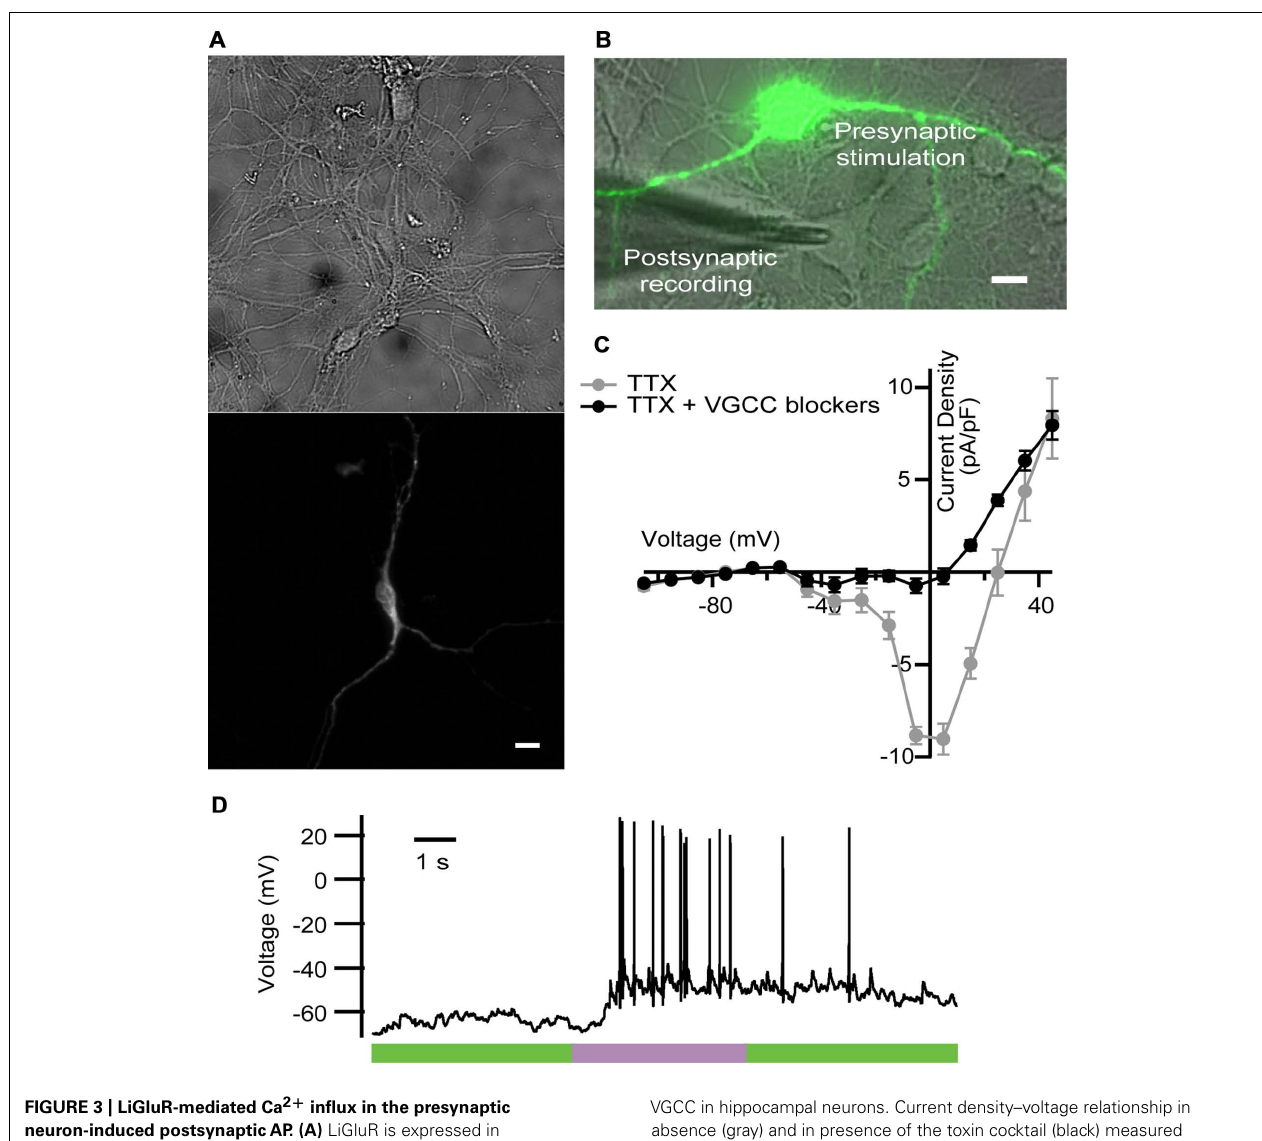
FIGURE 3 | LiGluR-mediated Ca 2 + influx in the presynaptic neuron-induced postsynapticAP. (A) LiGluR is expressed in the neuron soma and in all processes, as indicated by fluorescence from green fluorescent protein (GFP) fused to GluK2-L439C under a cytomegalovirus (CMV) promoter (top: bright field image; bottom: GFP). Scale bar, 10 μ m. (B) Image of the presynaptic LiGluR( + ) neuron (green fluorescence), and the glass pipette recording from a LiGluR( − ) postsynaptic neuron in contact with the green one. Scale bar, 10 μ m. (C) Quantification of the voltage-gated Ca 2 + current inhibition by the toxin cocktail against